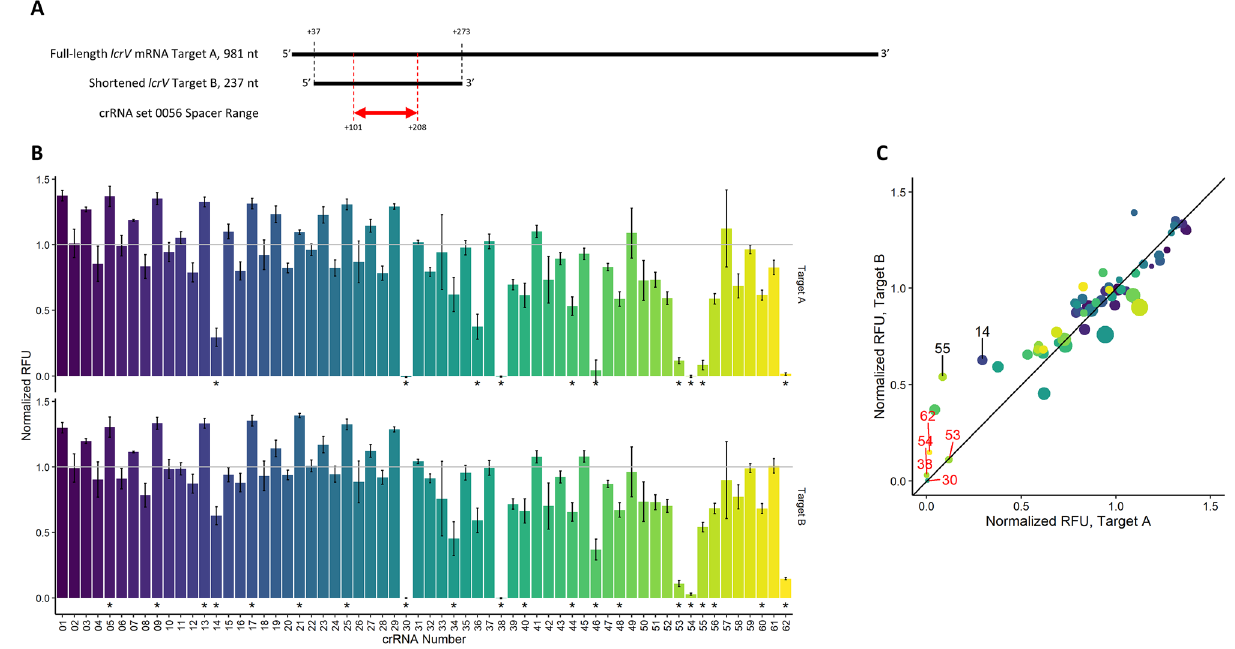
Figure 6. ( A ) Schematic of lcrV RNA of different lengths and the complementary region associated with crRNA set 0056. ( B ) Comparison of fluorescence sums normalized to internal control between different target lengths (Target A and Target B, as defined in panel A), where bars represent mean and error bars represent standard deviation (n = 3). ( C ) Comparison of normalized fluorescence sums from different target regions, where values represent mean, dot size represents relative standard deviation (n = 3), red labels represent crRNAs bearing unimproved activity ( p -value < 0.5 as determined by analysis of variance and Tukey test against internal control) against both target lengths, and black labels represent Cas13a activation from crRNA that improved to within 50% of internal control after shortening target